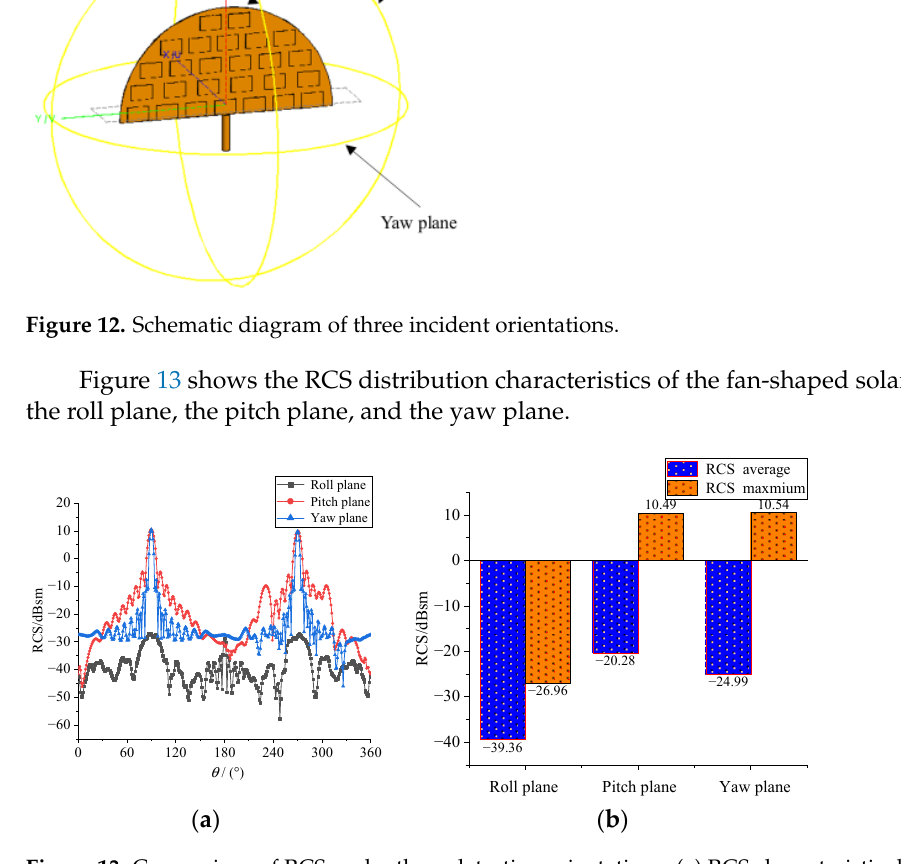
Figure 13. Comparison of RCS under three detection orientations. ( a ) RCS characteristic distribution; ( b ) RCS average and maximum.